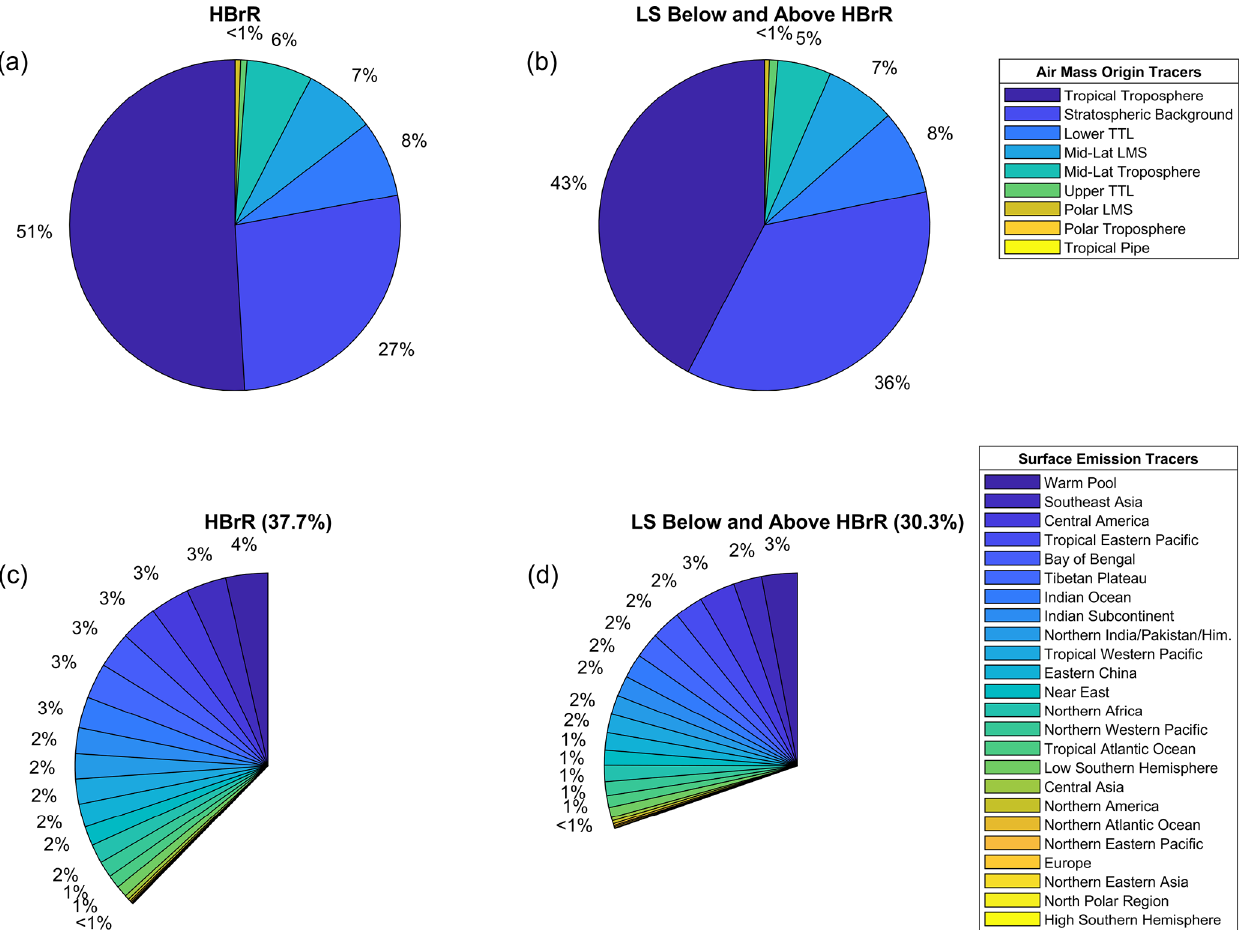
Figure 11. Relative contribution of the air mass origin (a–b) and surface emission (c–d) tracers during the WISE campaign obtained from CLaMS simulations. Contributions to the HBrR (between (cid:50) = 350–385K and equivalent latitudes 55 − 80 ◦ N) are shown in (a) and (c) , while the contributions to the LS air below and above the HBrR (i.e., from the local TP to (cid:50) = 350K as well as (cid:50) > 385K and between equivalent latitudes 55 − 80 ◦ N) are displayed in (b) and (d)